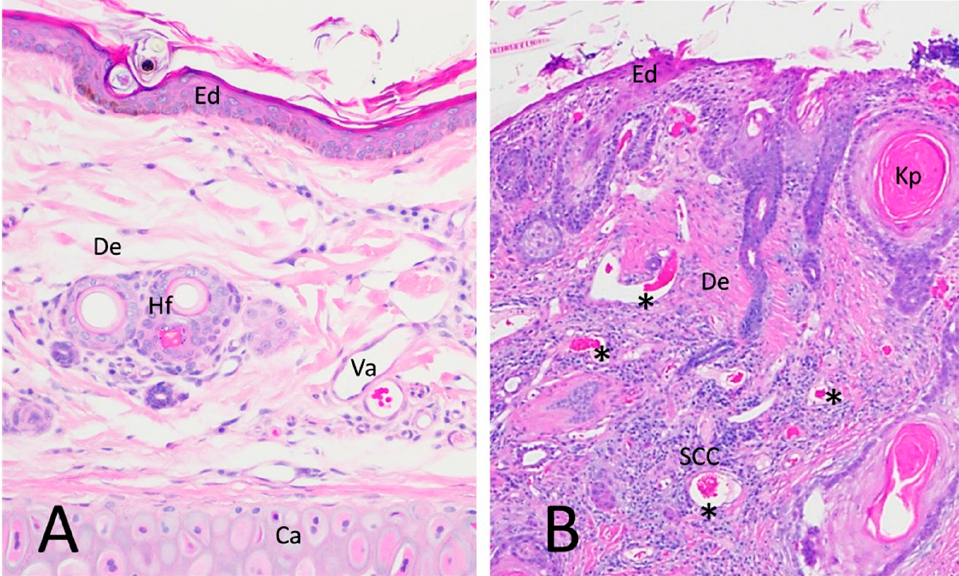
Figure 1. H & E microphotograph of normal haired skin (NHS) of the feline pinna and CSCC in a cat. ( A ) A surficial layer of flat keratin and multiple rows of intense basophilic keratinocytes form the epidermis (Ed). Deeper in the section is the dermis (De), with multiple hair follicles (Hf), small vasculature (Va), and adnexal glands, all distributed in a matrix of loose connective tissue. The lower part of the image has ear cartilage (Ca). ( B ) CSCC displaying invasive intradermal rafts of basophilic epithelial cells undergoing dysplastic and neoplastic keratinization (SCC), forming characteristic keratin pearls with a swirling glossy pink appearance (Kp). Intense proliferation of collagen fibers and blood vessels is present